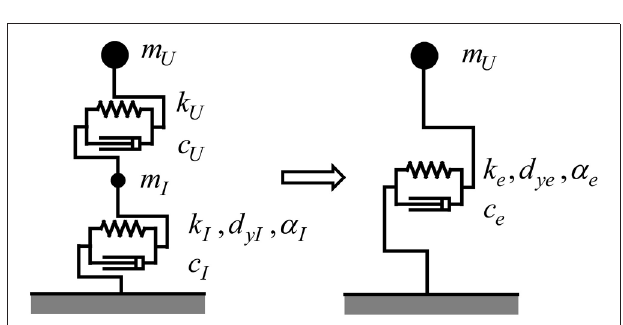
FIGURE 5 | Transformation of 2DOF system consisting of an SDOF superstructure and a base-isolation story into an SDOF system.